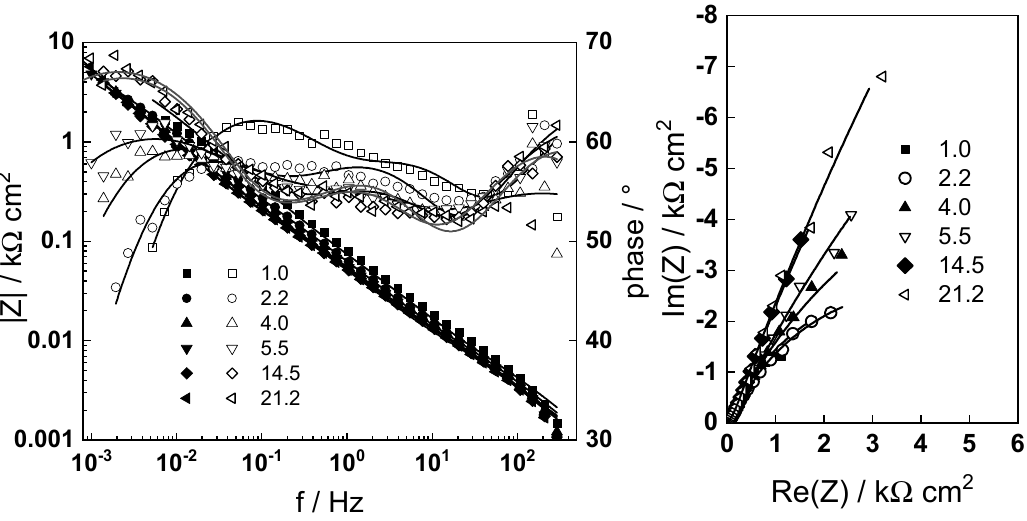
Figure 3. Electrochemical impedance spectra of AISI 316L at 130 ° С in AMETA water chemistry in the absence of magnetite particles. ( left )—impedance magnitude (full symbols) and phase shift (open symbols) vs. frequency, ( right )—complex plane representation. Points—experimental data, solid lines—best-fit calculation with respect to the MCM equations discussed in the text. The legend is oxidation time (h).